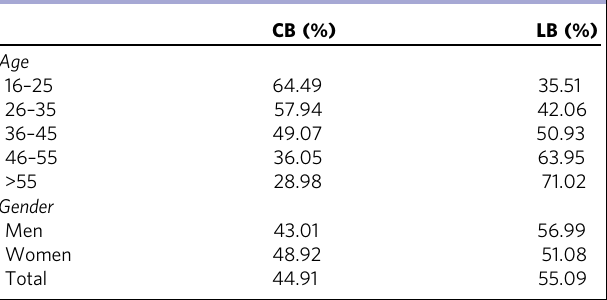
Table 2 Distribution by gender and age: CB vs. LB. Table 3 Convergent validity and reliability analysis.